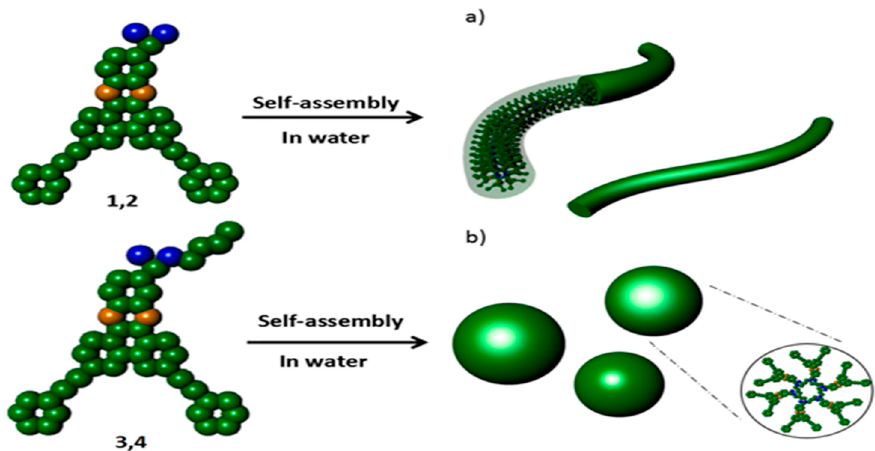
Figure 7. Schematic representation of the proposed self-assembly of molecules in aqueous solution: ( a ) nanofibers for 1 and 2 ; ( b ) micelle or nanoparticles for 3 and 4 , PEO chains are omitted for clarity.